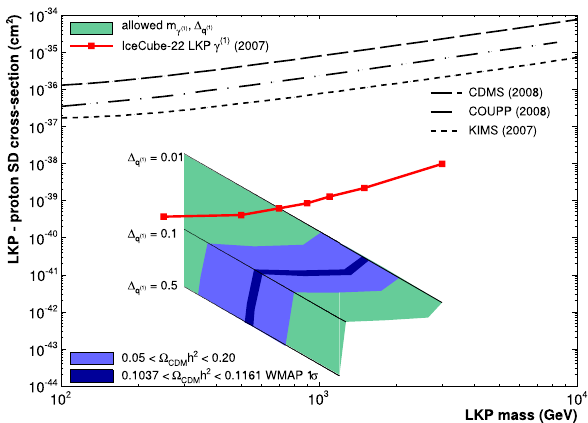
Fig. 24 IceCube limits on the spin-dependent LKP-proton scattering cross section, σ SD χ − p as a function of LKP mass, compared with limits from direct detectionexperiments [227–229]. The theoreticallyallowed phase space is indicated by the green shaded [230]. The region below m LKP = 300 GeV is excluded by collider experiments [231], and the upperboundon m LKP arisesfromargumentstoavoidover-closureinthe early universe [232]. The lighter blue region is allowed when consider- ing a wide range of dark matter relic density 0 . 05 < (cid:11) CDM h 2 < 0 . 20, and the darker blue region corresponds to the 1 σ WMAP relic density, 0 . 1037 < (cid:11) CDM h 2 < 0 . 1161 [233]. Figure reprinted with